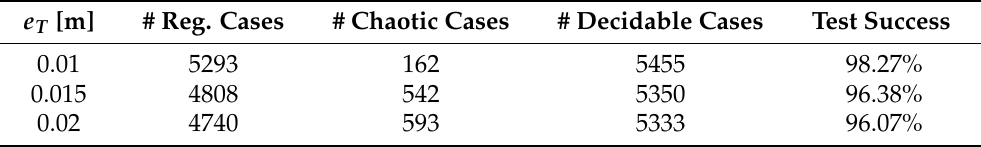
Table 2. Statistical success of the 0–1 test for